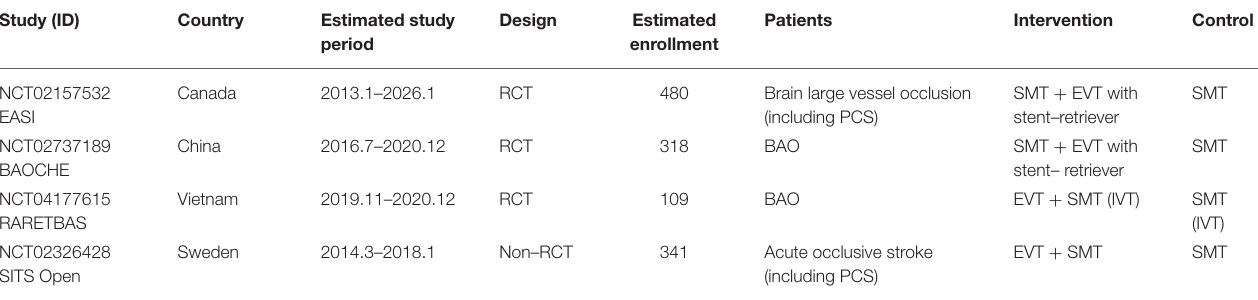
TABLE 3 | Characteristics of related ongoing/unpublished